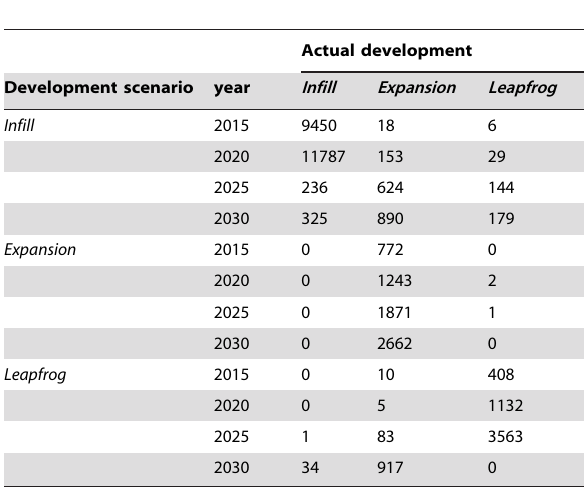
Table 2. Pattern of simulated development under infill, expansion, and leapfrog growth policies.